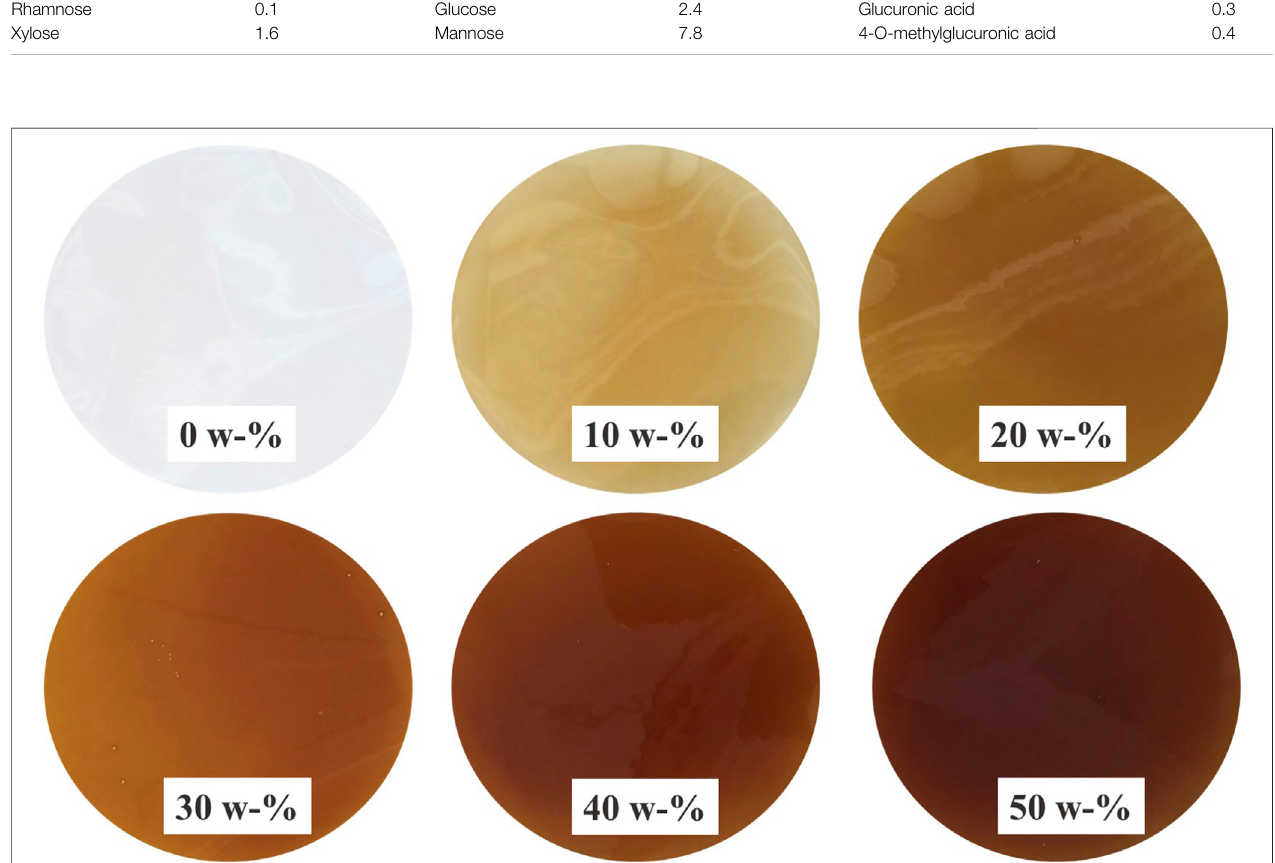
FIGURE 3 | Films with 0 – 50 w-% LCC 80/20 at 10 w-% interval, 95 – 45 w-% HEC and 5 w-% glycerol.